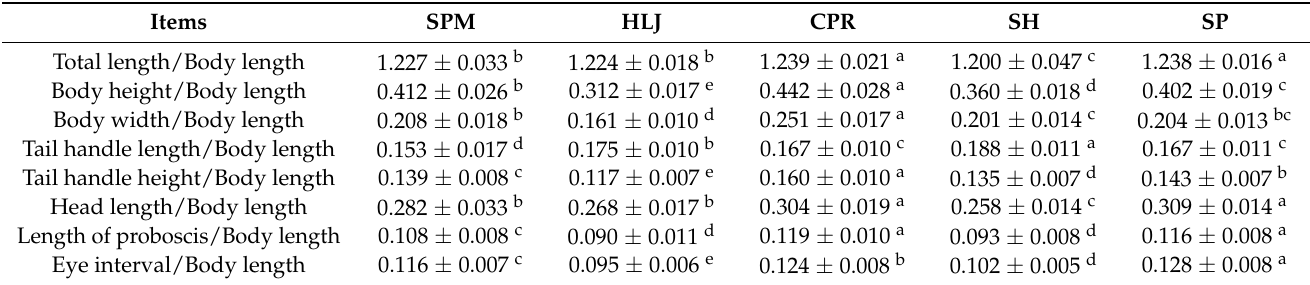
Table 3. Average statistics of the proportional traits of the five varieties of common